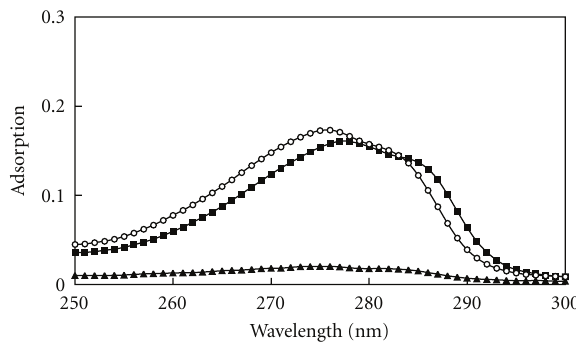
Figure 1: Absorbance of bisphenol A to MIP packed column, and elution from the column (cid:4) loading solution of bisphenol A,